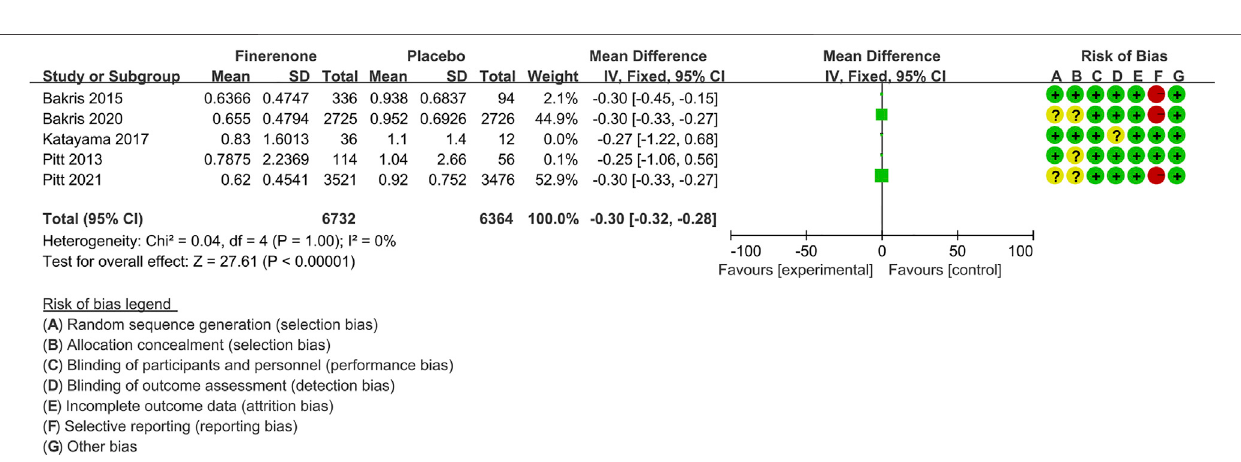
Frontiers in Pharmacology |